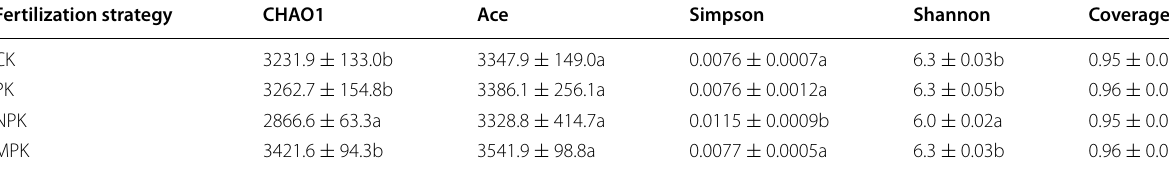
Values are mean standard deviation (n 6). Values within the same column followed by different lowercase letters indicate significant differences according to ± = Tukey’s multiple comparison tests. Operational taxonomic units defined based on a 97% similarity threshold